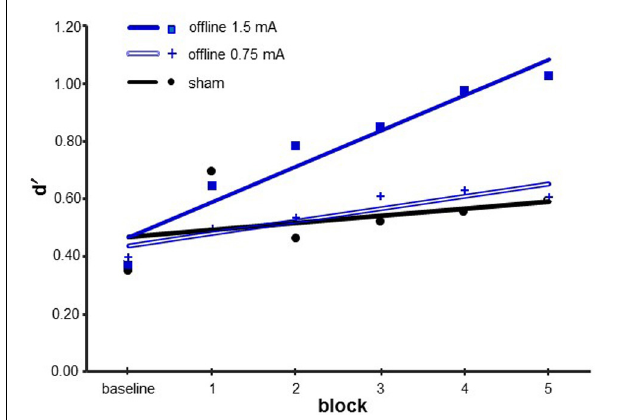
FIGURE 5 | Results of Experiment 3. Data are represented as the mean d (cid:4) values. The lines represent the fit of each condition. The blue line represents the offline 1.5mA for the 22min condition. The double blue line represents the offline 0.75mA for the 22min condition. The sham condition is shown in black.